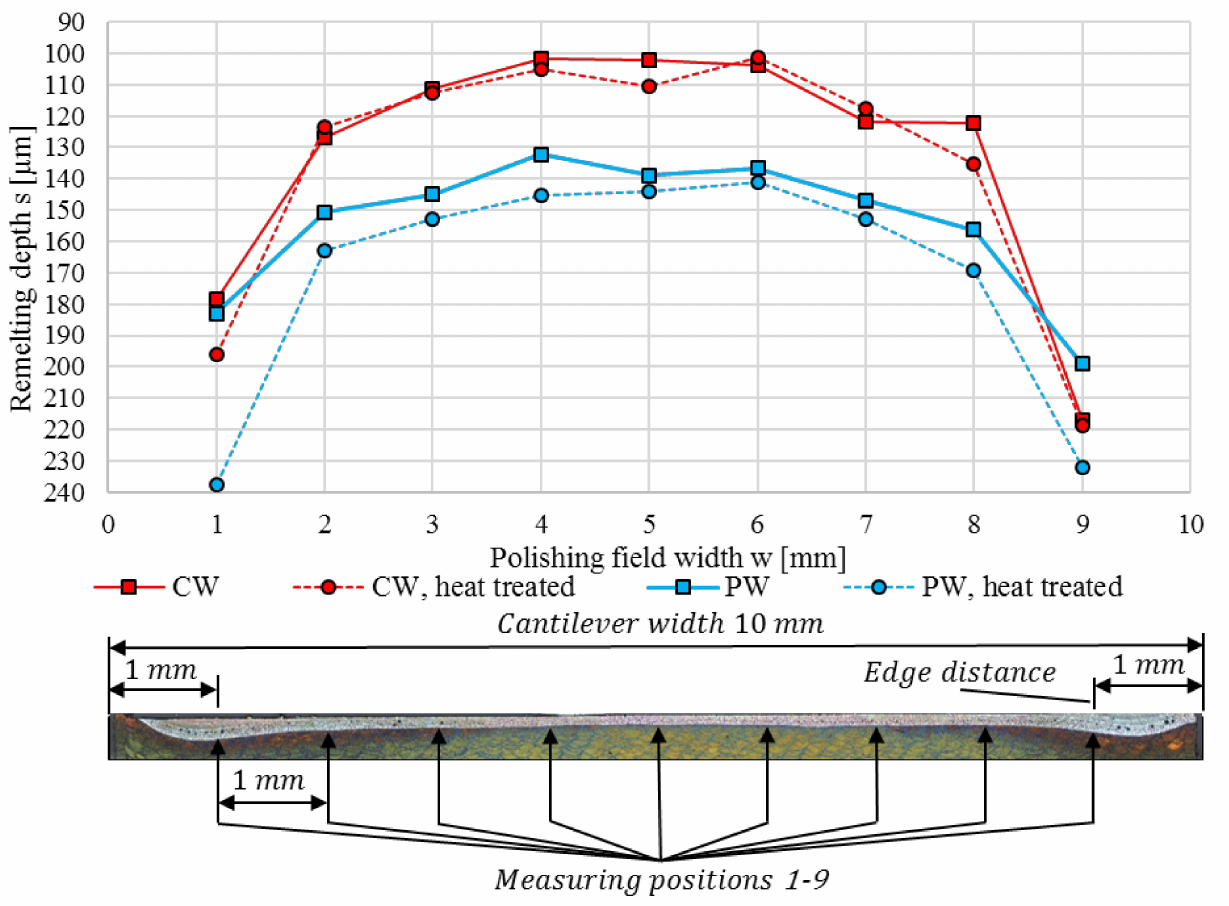
Figure 10. Remelting depth, measured at the cross section at the centre of the